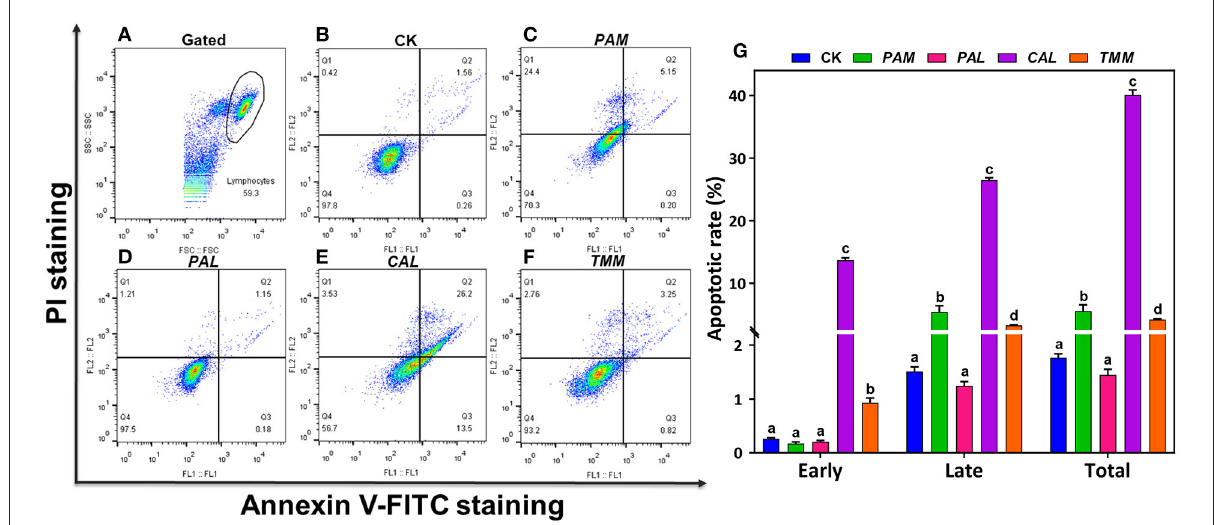
FIGURE4 Apoptosis of HGEC after being exposed to extracts for 24h. FL1 represents Annexin V-FITC staining and FL2 represents PI staining. HGEC populations ( A ; black circle) and apoptosis in the control group ( B ; CK). Apoptosis of HGEC after being exposed to PAM (C) , PAL (D) , CAL (E) , and TMM (F) extracts: necrotic cells were shown in the Q1 quadrant, viable (late) apoptotic cells and non-viable (early) apoptotic cells were distributed in Q2 and Q3 quadrant, Q4 quadrant was living cells. The statistical graph showed cell apoptosis rate under different treatments (Q2 + Q3 quadrant) (G) . Data were presented in mean ± SD. The different letters indicate significant differences ( p < 0.05).